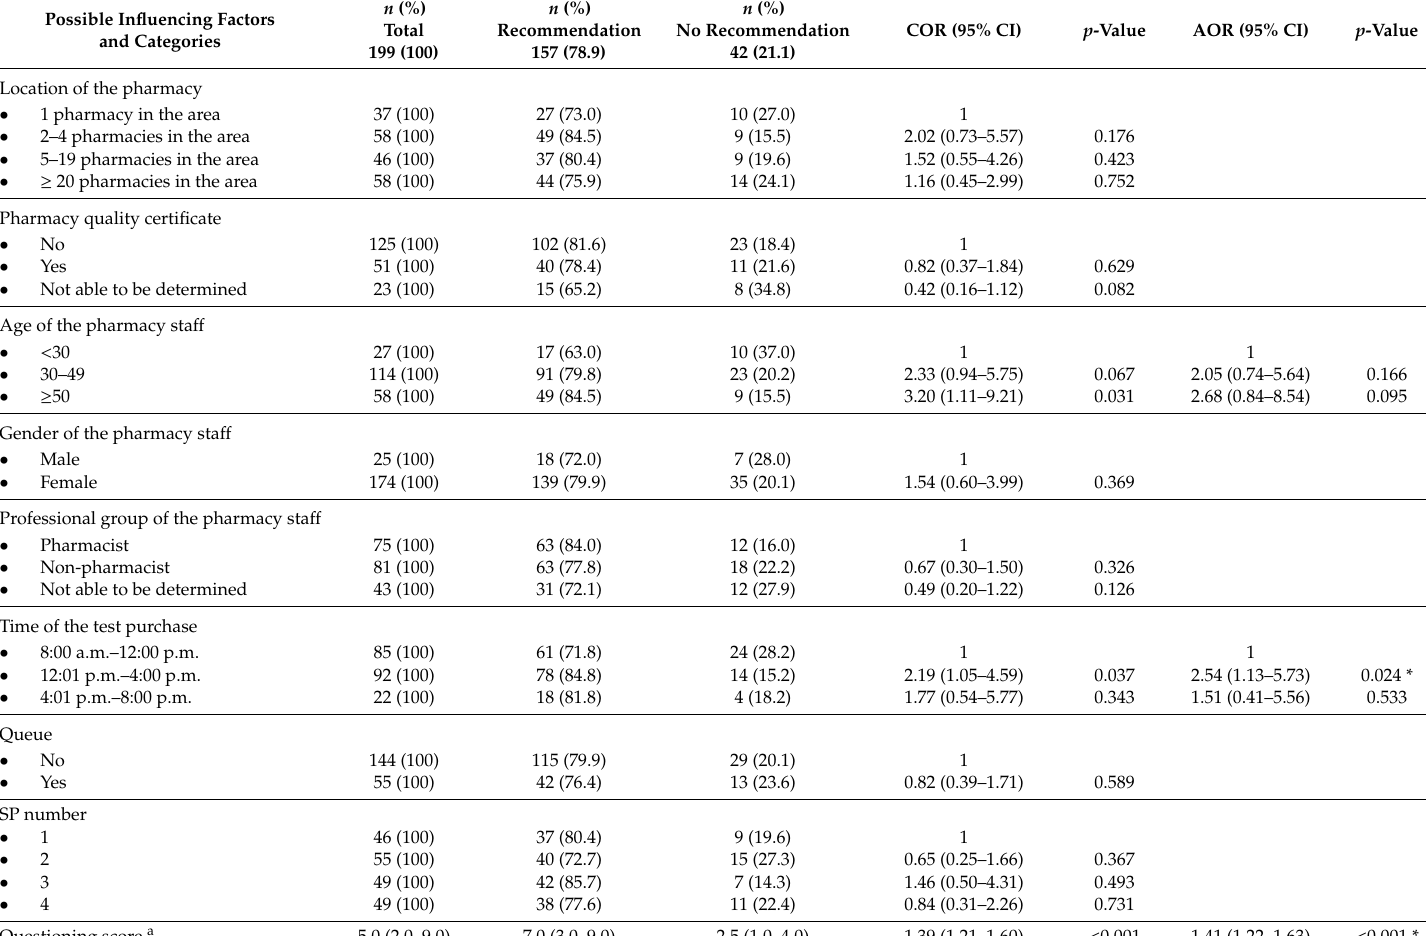
Table 6. Possible influencing factors on the recommendation of